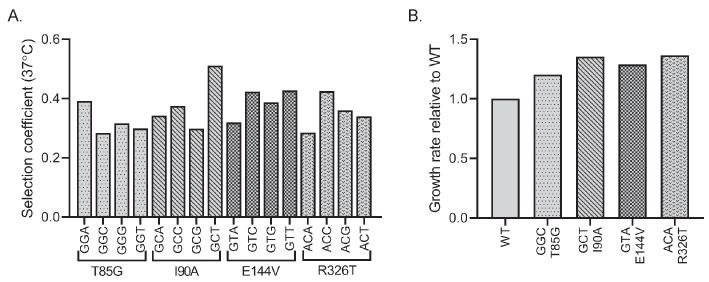
Validation of beneficial mutants at37°C.(A) Selection coefficients of synonymous codon variants for four amino acid mutants with beneficial selection coefficients at 37°C show high correlation. (B) The same individual variants analyzed in isolation exhibit increased growth rates.